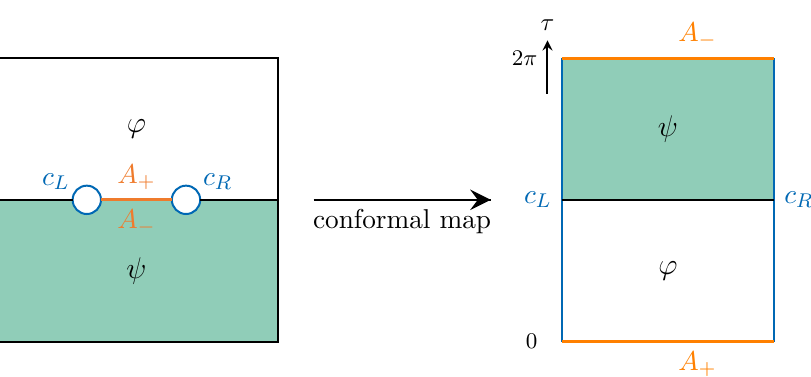
Figure 15 . The pseudo entropy for an interval in CFT 2 [Left] and the conformal transformation to the cylinder